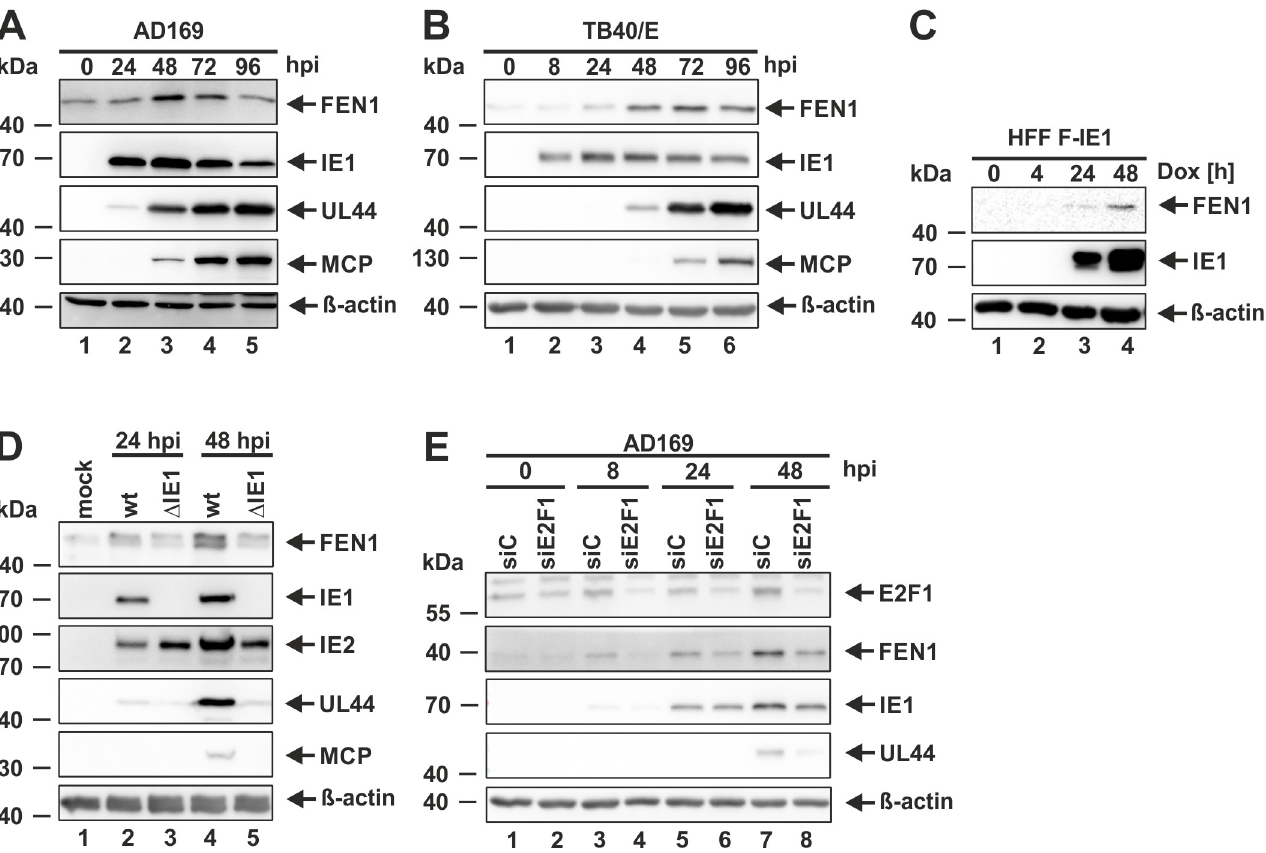
Fig 3. IE1-mediated upregulation of FEN1 during HCMV infection. (A, B, and D) HFF cells were either mock infected or infected with AD169 at an MOI of 3 (A), with TB40/E at an MOI of 1 (B), or with AD169 (wt) at an MOI of 7 and equivalent genome copy numbers of a recombinant strain lacking IE1 ( Δ IE1) (D). At the indicated times post infection, cells were harvested and analyzed by Western blotting for FEN1, IE1, IE2 (for D), UL44, MCP, and β -actin. (C) HFF FLAG (F)-IE1 cells with doxycycline-inducible expression of FLAG (F)-IE1 were either not induced or induced with 0.5 μ g/ml doxycycline for the indicated times. Cells were harvested analyzed by Western blotting for FEN1, IE1, and β -actin. (E) HFFs, which were treated for 24 h with 50 nM of a control siRNA (siC) or a siRNA targeting E2F1 (siE2F1), were infected with AD169 at an MOI of 3. At the indicated times post infection, cells were harvested and analyzed by Western blotting for E2F1, FEN1, IE1, UL44, and β